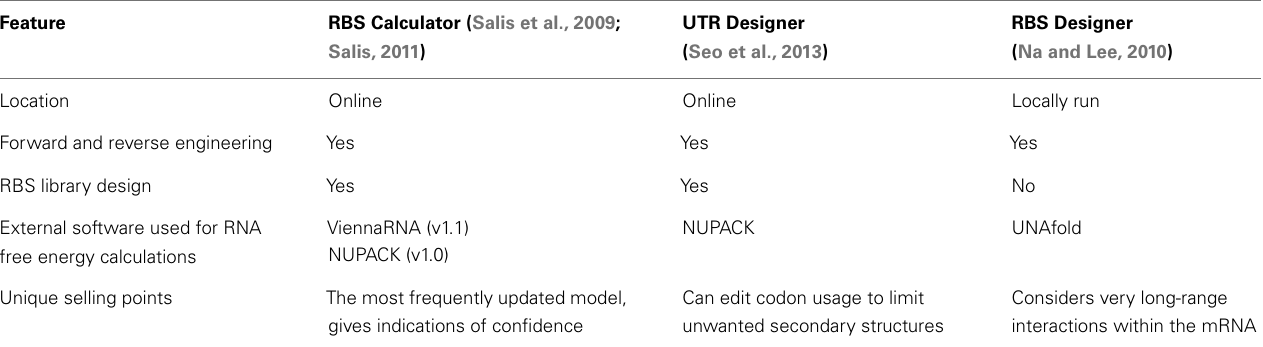
Table 1 | Key differences between the calculators